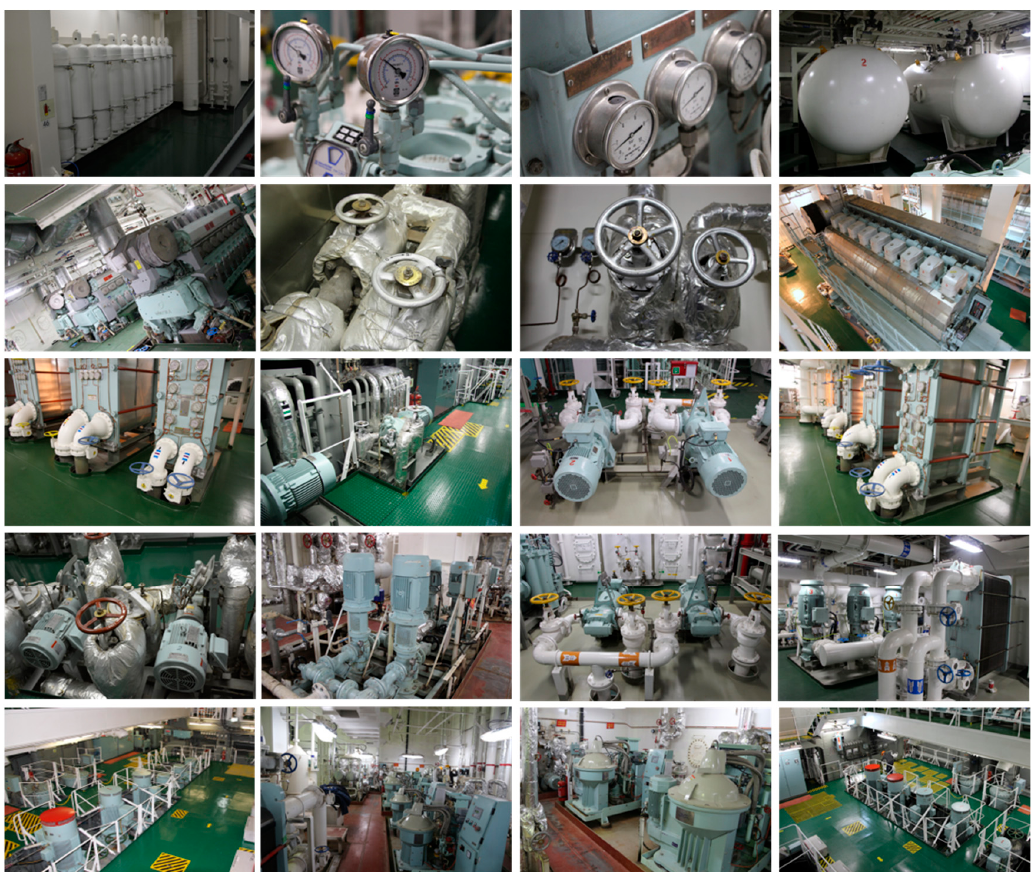
Figure 9. The original image samples in the AEMER.